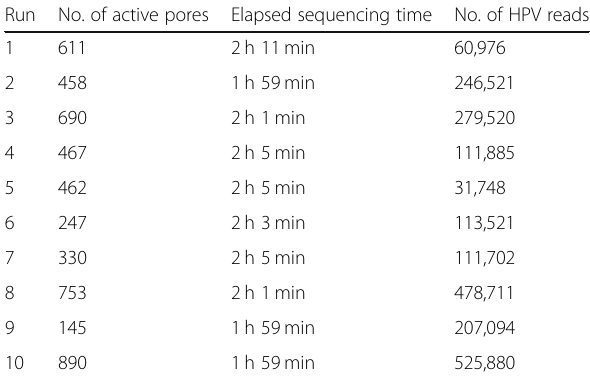
Table 3 Master mix constituents and PCR conditions Table 4 Details of Nanopore sequencing